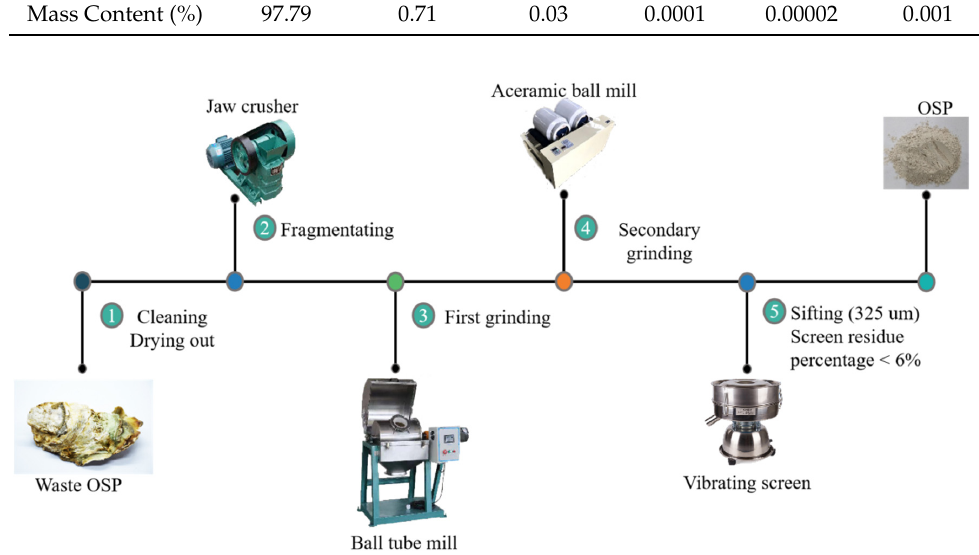
Figure 4. Preparation process of OSP.